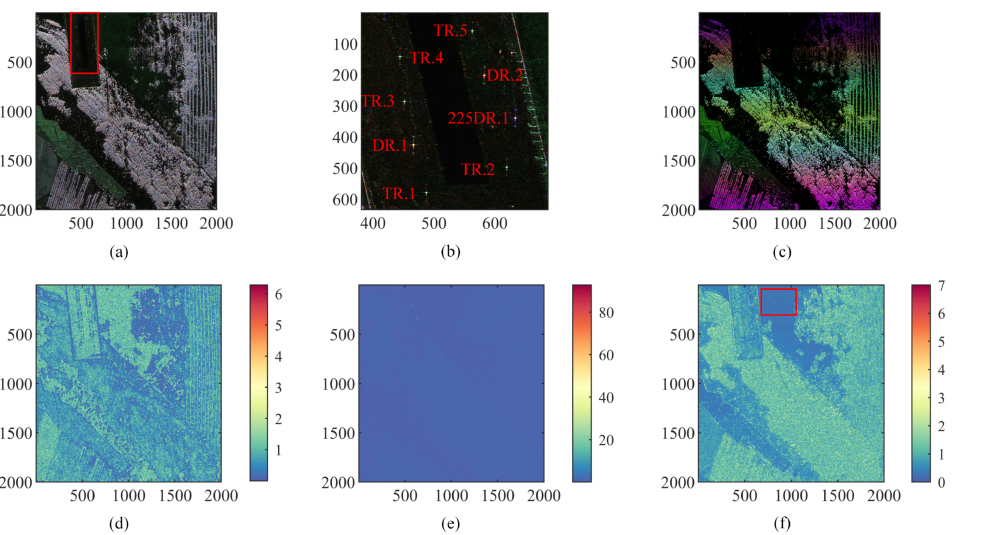
Figure 6. L-band CQP SAR images: ( a ) the true Pauli RGB CQP SAR image, where the red channel − S rr | 2 , the green channel is 1 | S is 1 ll 2 illuminated the scene from top to bottom; the airport location is marked in red; ( b ) enlarged view of the near range in ( a ); ( c ) simulated uncalibrated Pauli RGB image; ( d ) ENL image; ( e , f ) R vb images with different scales; the red box in ( f ) marks bright